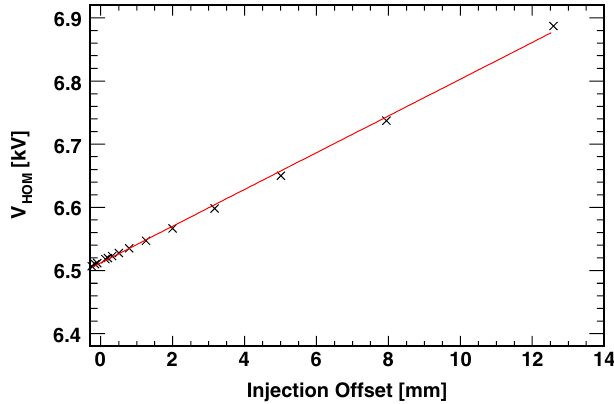
FIG. 34. Maximum observed HOM voltage in the high beta section as function of the injection error and a linear fit through the data. Settings: N ¼ 100 , see Table